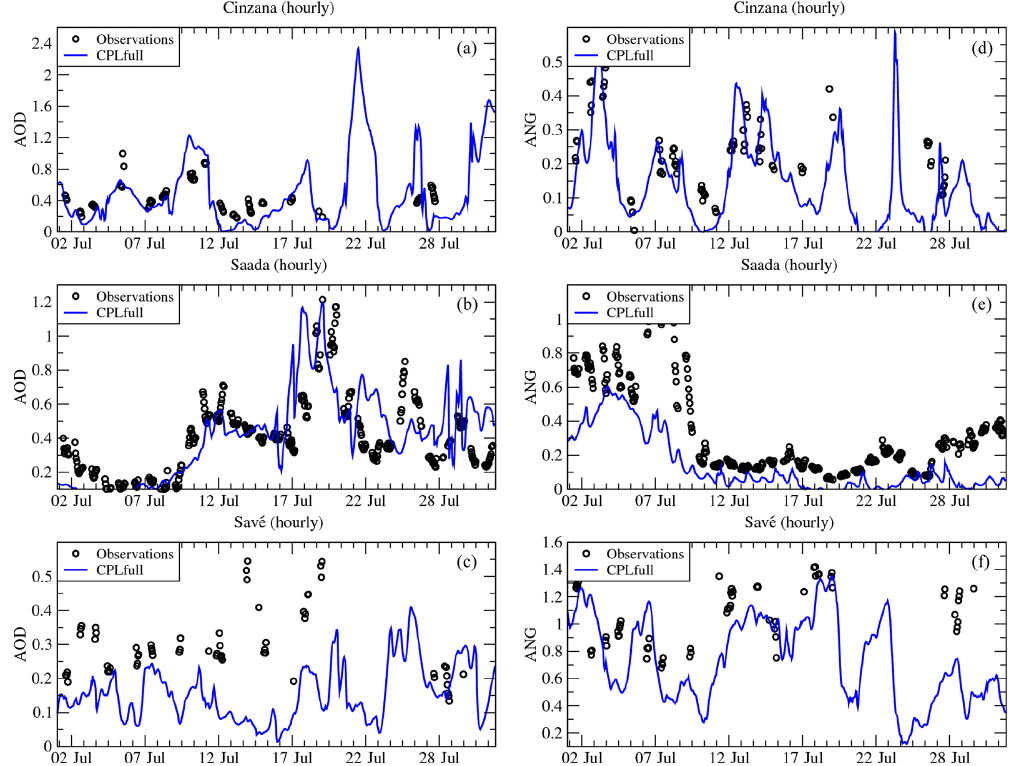
Figure 3. Aerosol optical depth (at wavelength λ = 600nm; a , b , c ) and Ångström exponent (d, e, f) time series in Cinzana, Saada and Savé and for July 2016.